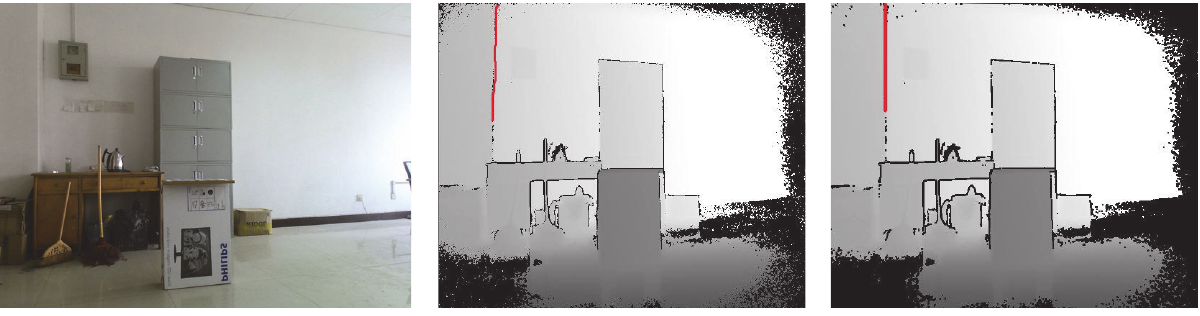
Figure 4: Depth image with calibration.